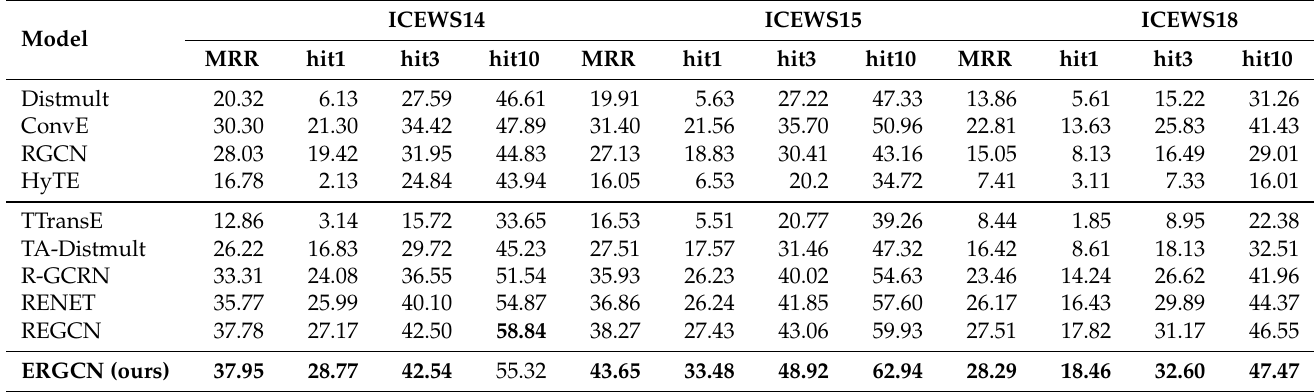
Table 2. Experimental results of entity prediction on ICEWS14, 15 and 18 in raw metrics.